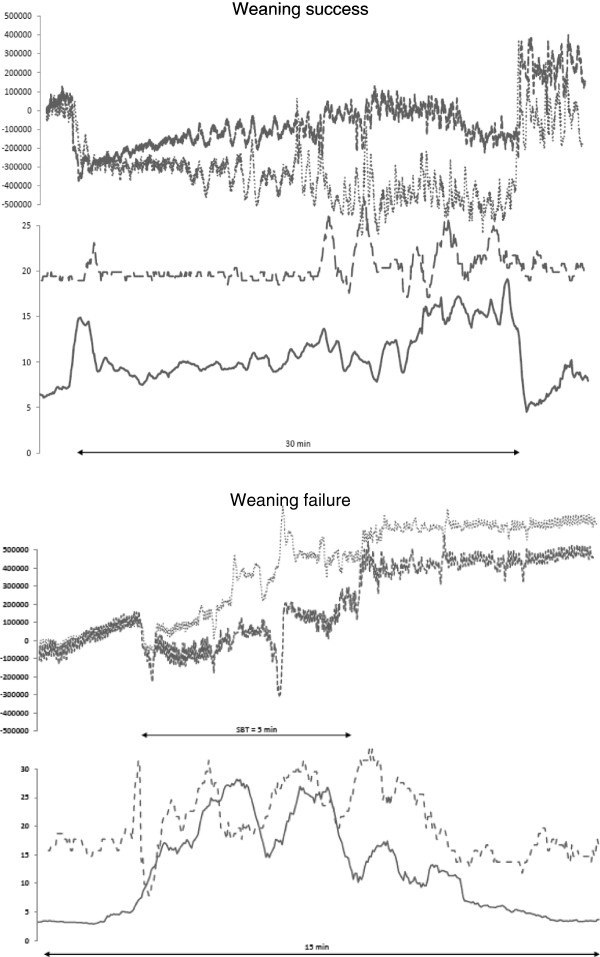
Electrical activity of the diaphragm (EAdimax), respiratory inductive plethysmography (RIP), and respiratory rate (RR) tracings (y-axes) over time (x-axis) of a success (number 6) and a failure patient (number 2) during a spontaneous breathing trial (SBT). The figure shows patient 6 successfully passing the SBT (top), and patient 2, who failed to pass the SBT (bottom). The horizontal line (number 6 SBT, 30 minutes; number 2 SBT, 5 minutes) indicates the duration of the SBT. In each patient, the upper part of the graph shows the RIP tracings from the thoracic (fine dots) and abdominal band (bold dots); the lower part shows the respiratory rate (dashed line) and the EAdimax (solid line). Note the steep increase in EAdimax in patient 2 after disconnection from the ventilator.